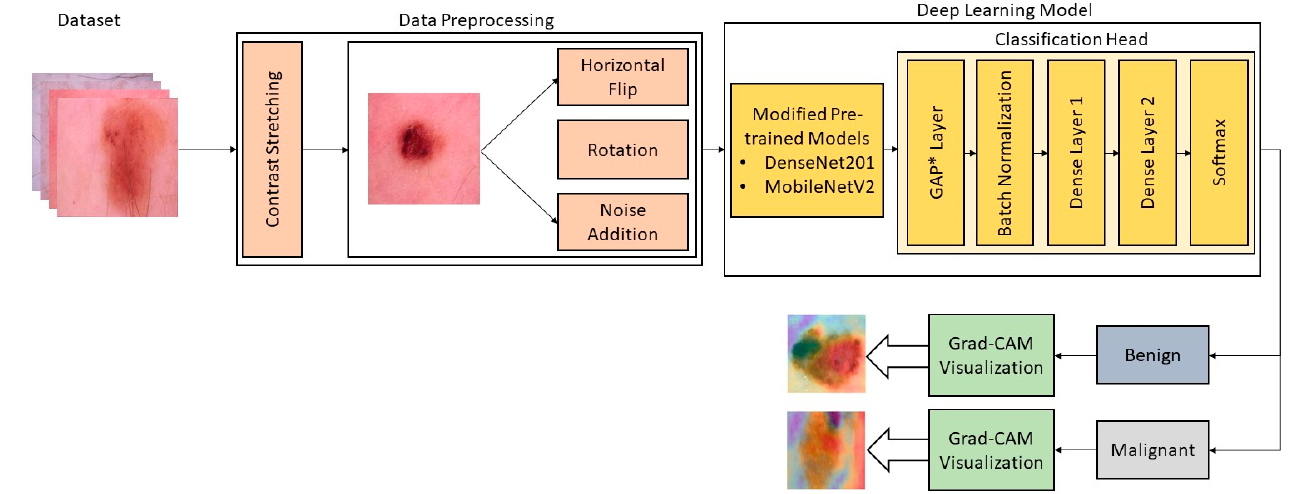
Figure 1. The workflow of the proposed technique for skin cancer classification.